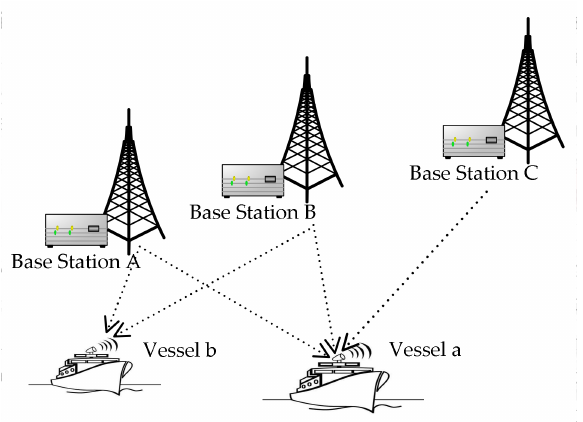
Figure 1. Scene of the automatic identification system (AIS) ranging mode (R-Mode) with two base stations.